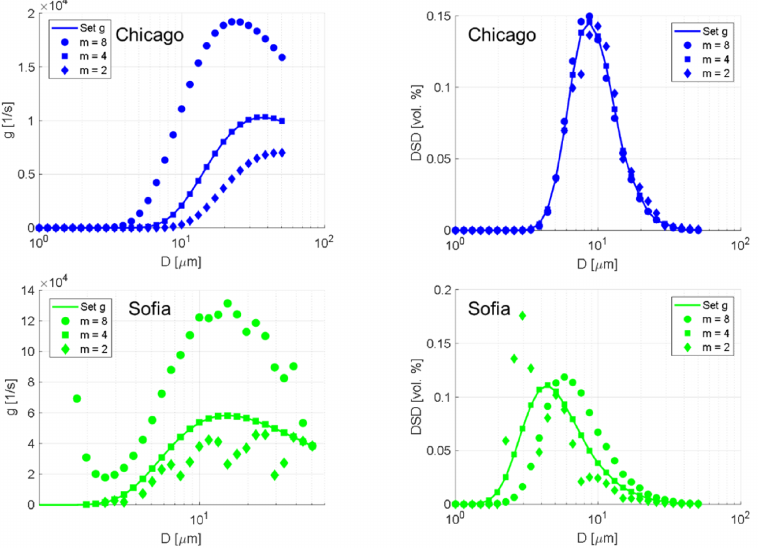
Figure 5. Sensitivity of the different methods to the choice of m . Left column compares set fragmenta- tion rates obtained by m = 4 (solid lines) to estimations using a range of assumed m values ( m = 2, 4, and 8). The right column compares the validation data DSD after 20 passages (solid lines), to the DSD predicted based on different m assumptions. Showing the Sofia method (top row) and the Chicago method (lower